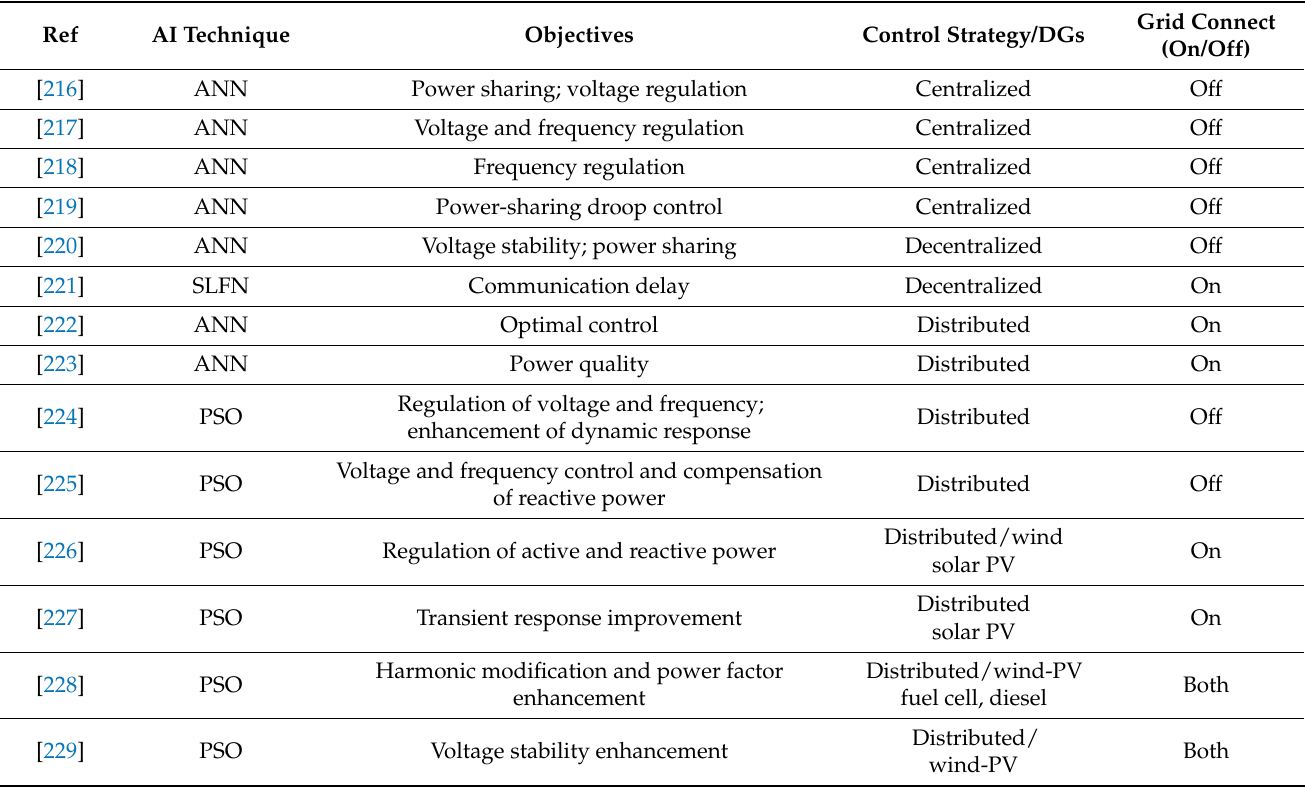
Table 4. AI-based control for fault dynamic response and power quality enhancement of MGs